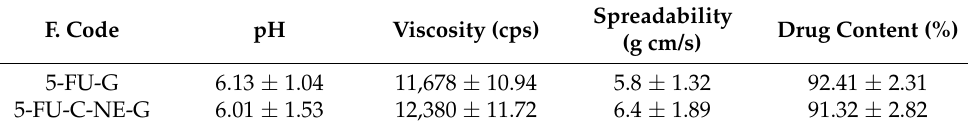
Table 3. Physicochemical characterization of the nanoemulsion